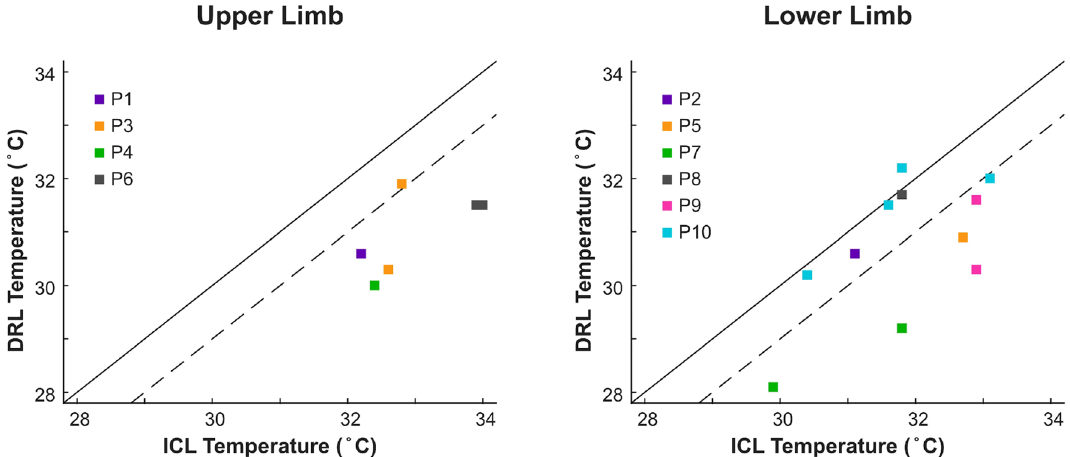
Figure 3. Skin temperature asymmetry: Intact contralateral limb (ICL) versus distal residual limb (DRL) temperature on conventional prostheses-users. Solid line corresponds to thermal symmetry between the limbs. Dashed line corresponds to DRL 1 ̊ C cooler than